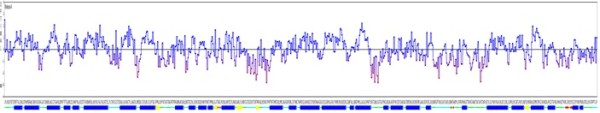
Overall quality of predicted RB1 model.